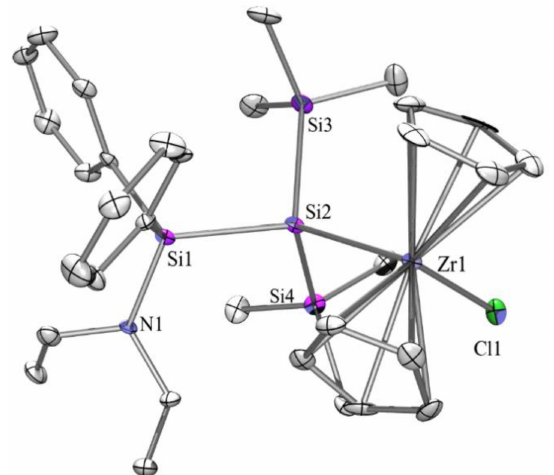
Figure 5. Molecular structure of 3a (thermal ellipsoid plot drawn at the 30% probability level). All hydrogen atoms are omitted for clarity. About 20% of the chloride position is occupied by bromide (bond lengths in Å, angles in degrees). Cl(1)-Zr(1) 2.4565(19), Zr(1)-Si(2) 2.863(2), Si(1)-Si(2) 2.387(3), Si(1)-N(1) 1.741(6), Si(1)-C(15) 1.881(8), N(1)-C(11) 1.438(10), C(1)-C(2) 1.392(13), Si(3)-Si(2)-Si(1)